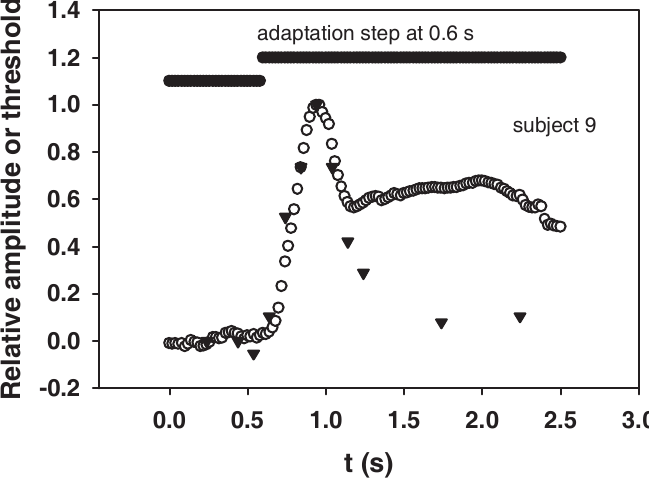
Figure 7. Electroretinogram (circles) and electroretinographically determined increment thresholds (triangles) for subject 9 (both courses standardized). The threshold curve has been shifted in such a way that the maximum coincides with the maximum in the electroretinogram (peak of the b-wave). This displacement to the right (to higher times) is 0.1